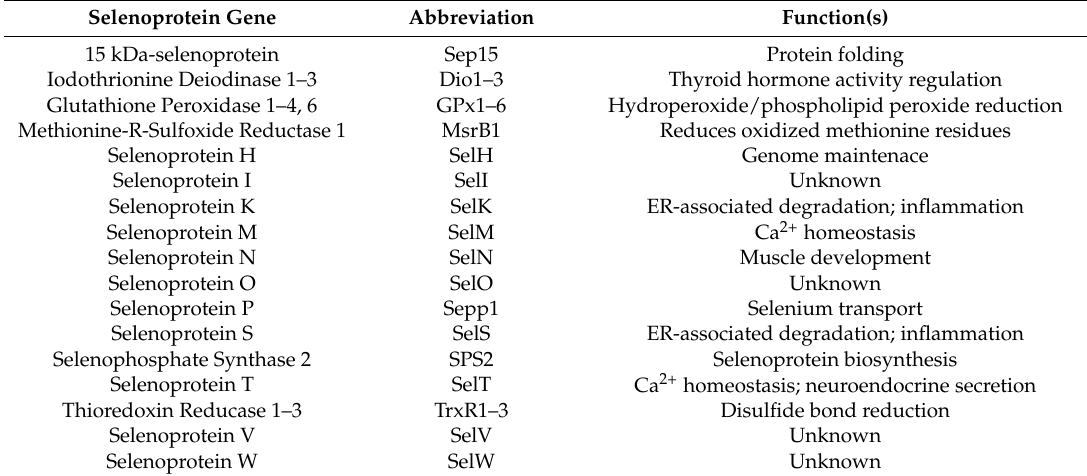
Table 1. List of identified mammalian selenoprotein genes and their known functions. Selenoprotein Gene Abbreviation Function(s) Sep15 Protein